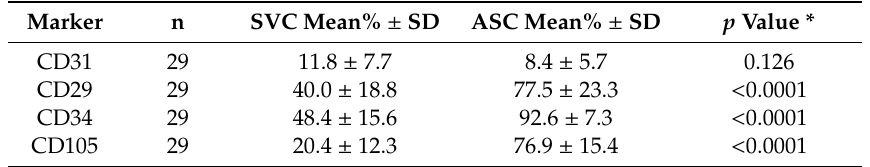
Table 1. Endothelial and adipose tissue stromal cell marker expression in stromal-vascular cells (SVCs) and ASCs. Analyses were performed on CD45 –